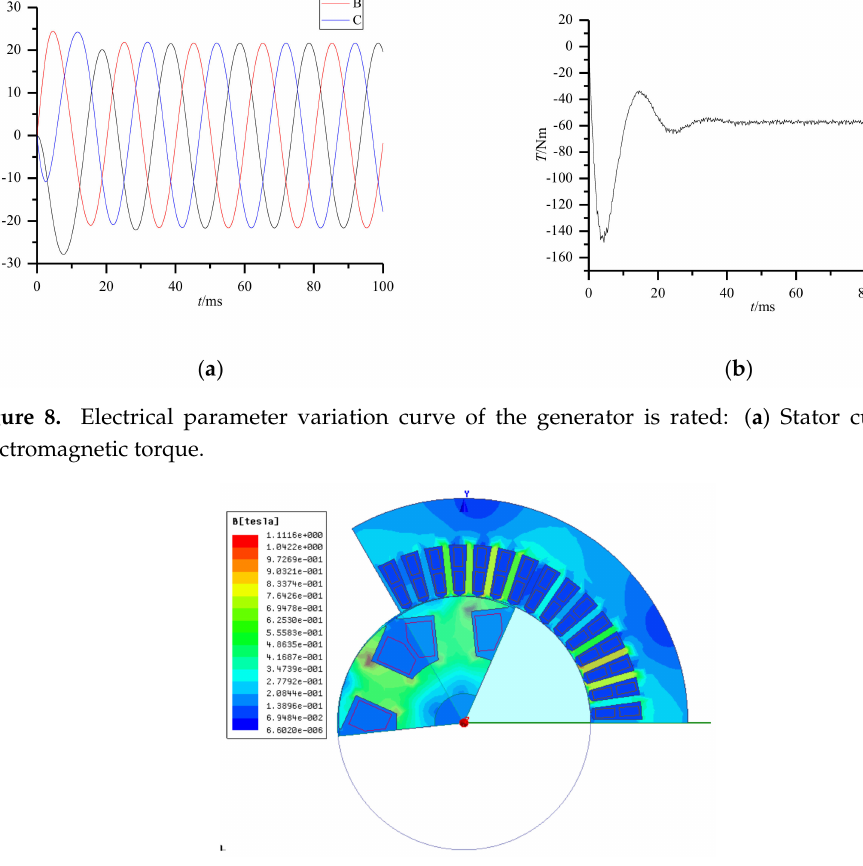
Figure 9. Magnetic flux density distribution of the generator is